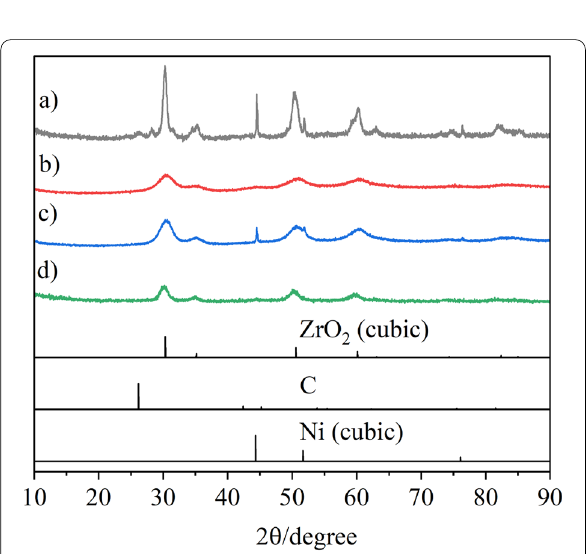
Fig. 9 XRD patterns of spent catalysts for a S -Ni@ZrO 2 , b S -Ni@